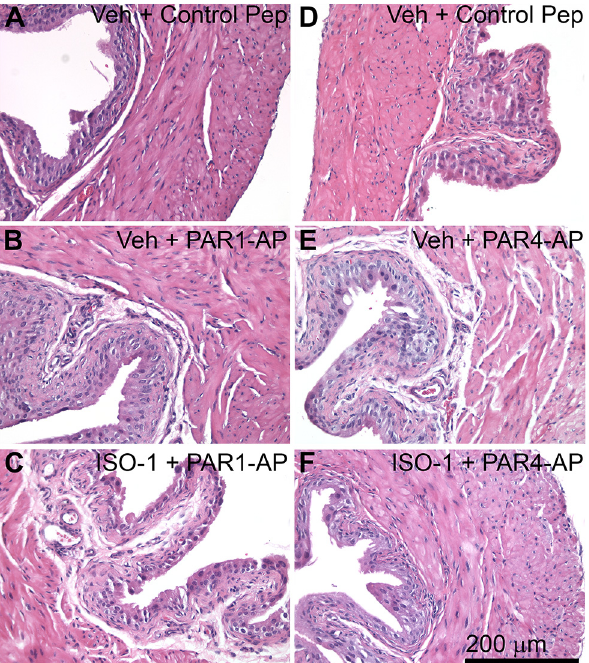
Fig 5. Activating urothelial PAR1 or PAR4 did not result in bladder inflammation. H&E stained paraffin bladder sections showed normal bladder and urothelial morphology in mice in the control group ( A , D ; vehicle pre-treatment, intravesical scrambled peptide). Intravesical treatment with PAR1-AP ( B ) or PAR4-AP ( E ) did not alter morphology. Pre-treatment with ISO-1 also had no effect ( C , F ).